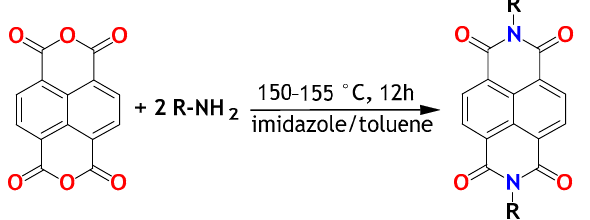
Figure 2. Synthesis of NDIs. R = n-propyl (NDIC3); R = n-butyl (NDIC4); R = n-pentyl (NDIC5); R = n-hexyl (NDIC6); R = n-heptyl (NDIC7); R = n-octyl (NDIC8); R = n-nonyl (NDIC9); R = n-decyl (NDIC10); and R = n-undecyl (NDIC11).